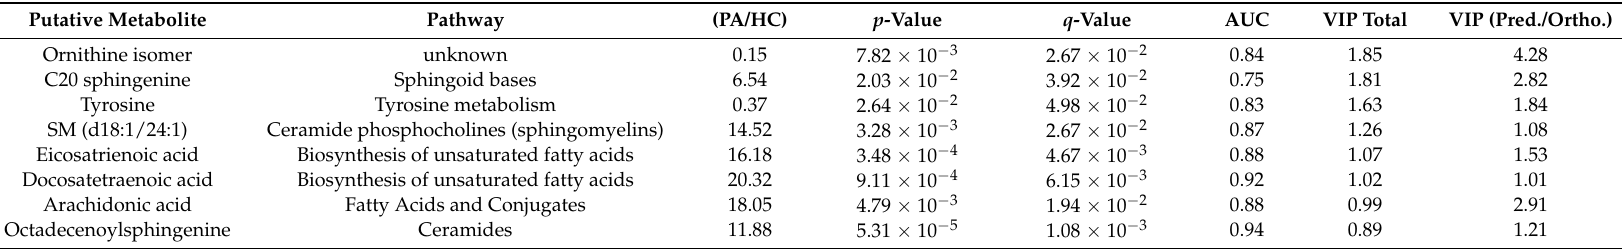
Table 3. List of metabolites that were significantly different in the pre-EEN treatment group (PA) compared to the healthy controls (HC), based on an OPLS-DA model. All marker compounds were normally distributed according to a Q-Q